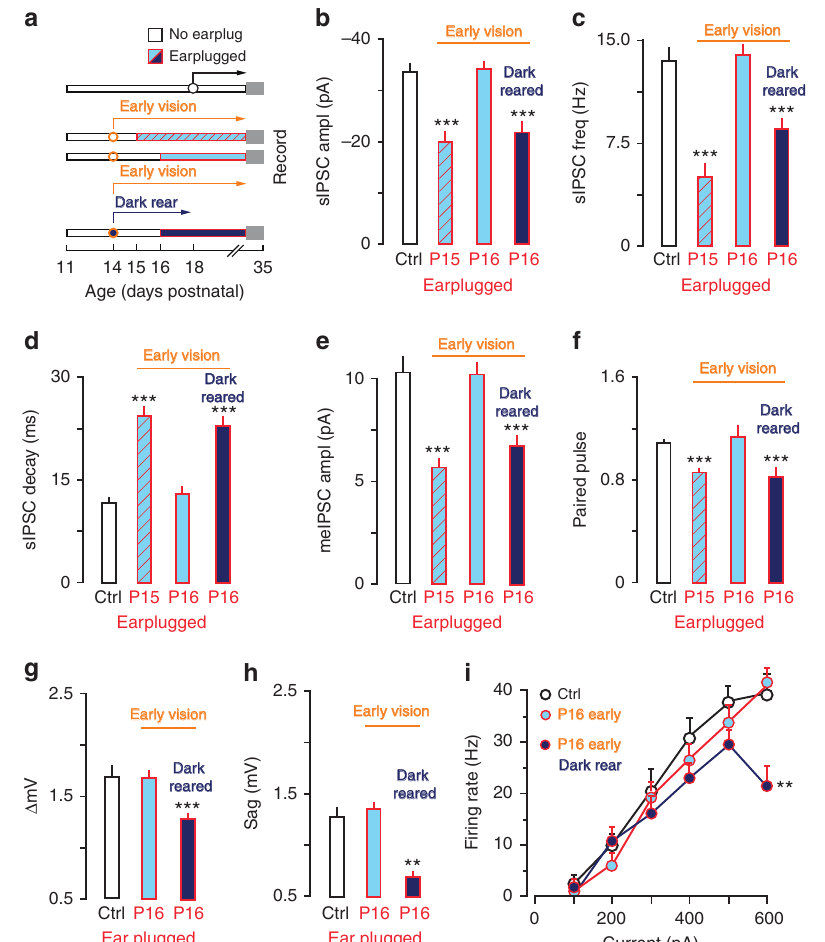
Figure 2 | Early visual experience causes precocious closure of the ACx CPs of sensitivity to hearing loss. ( a ) Diagram shows the experimental design for data presented in b – i . Eyes were opened prematurely at P14 and ears were plugged on P15 or P16. Some animals receiving earplugs on P16 were dark reared from P14 to P17. Sample size; IPSCs: Control, n ¼ 40; P15, n ¼ 12; P16, n ¼ 14; P16 Dark rear, n ¼ 21; Intrinsic: Control, n ¼ 57; P16, n ¼ 26; P16 Dark rear, n ¼ 16. ( b – d ) Bar plots show that after early eyelid opening, sIPSC amplitude and frequency were diminished and decay time constant was slower when earplugs were inserted on P15, but not P16. Early CP closure was prevented by dark rearing. ( e , f ) Bar plots show that after early eyelid opening meIPSC amplitude was diminished and PPRs were depressed when ears were plugged at P15, but not P16. Dark rearing prevented early closure of the CP. ( g – i ) Bar plots show that after early eyelid opening the D mVdid not decrease, depolarizing sag was not reduced and there was not a decrease in firing rate when ears were plugged on P16. Dark rearing prevented early closure of the CP. Experiments were not replicated. Tukey’s (honestly significant